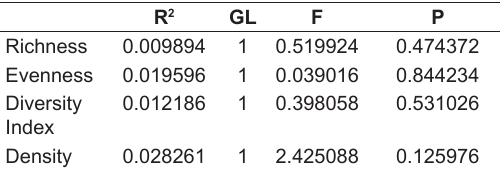
Table 2. Results obtained by the simple linear regression analysis for the attributes of the Oligachaeta assemblage, using as a predictor variable the sediment diversity.